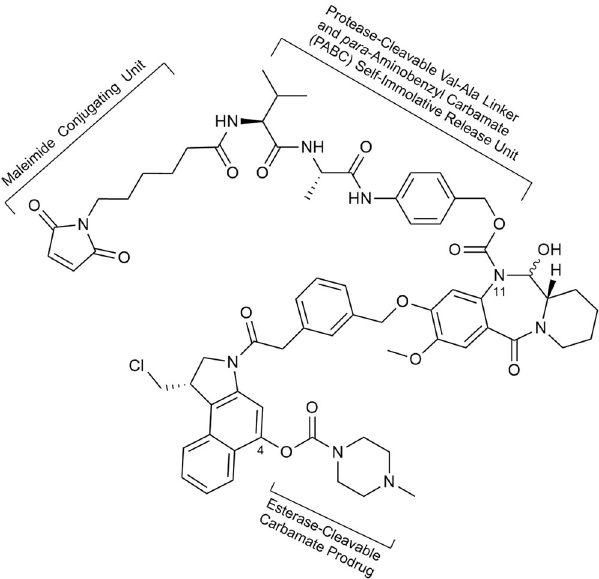
Fig. 7 Structure of the Maleimide-Val-Ala-PABC-(FGX8-46) Linker-Payload construct FGX16-11 ( 9